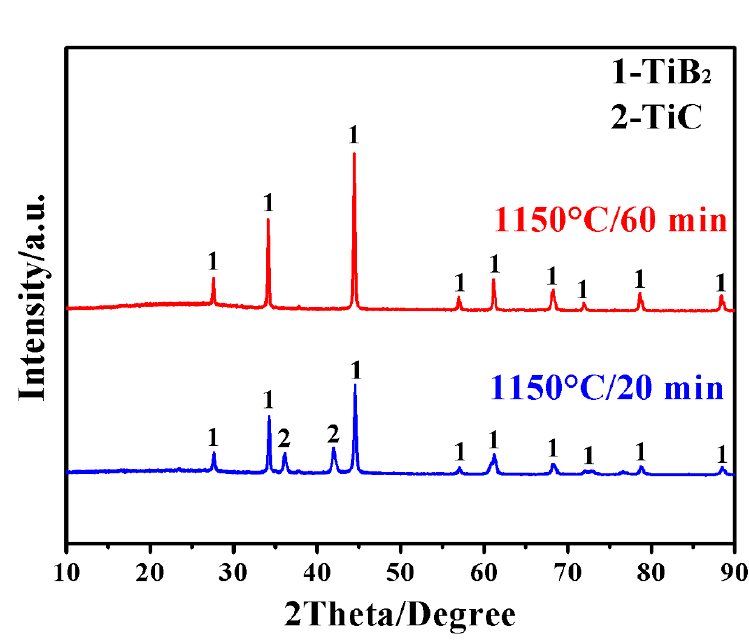
Figure 1. Phase formation in samples prepared by MSM-BCTR at 1150 °C for respectively 20 and 60 min.